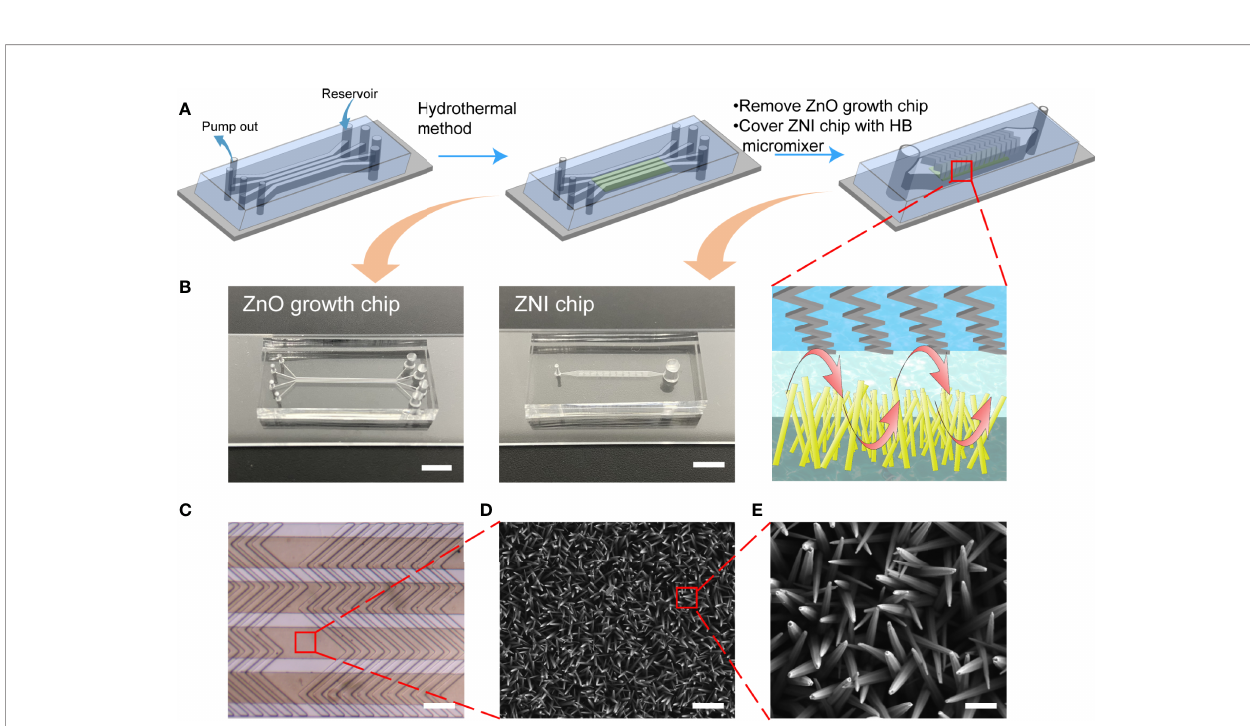
FIGURE 2 | The fl ow chart of manufacturing the ZNI chip. (A) The ZnO nanoarray was prepared in ZnO growth chip by a hydrothermal method. 4 groups of nanoarrays were prepared simultaneously. Then, the ZnO growth chip was peeled off and bonded the chip with the herringbone (HB) micromixer structure to the top of the nanoarray to complete the assembly of the device. (B) Photographic image of the ZnO growth chip and ZNI chip. Scale bar: 4mm. (C) Stereoscope image of ZNI chip. Scale bar: 200 m m. (D , E) Scanning electron microscope (SEM) micrographs of ZnO nanorods. (D) Scale bar: 1 m m. (E) Scale bar: 200nm.